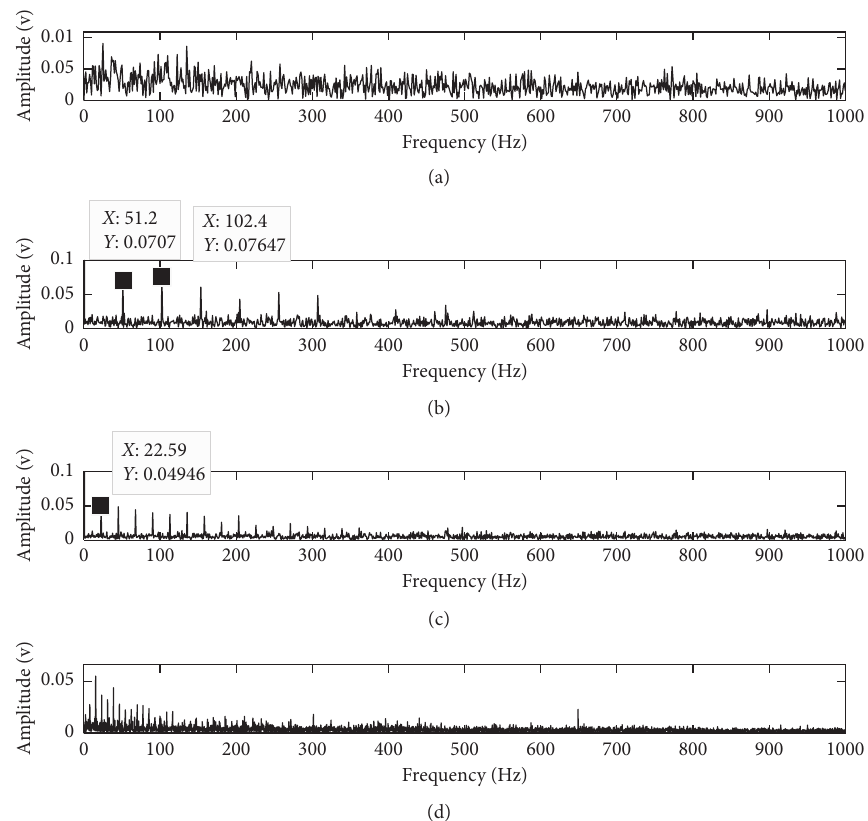
Figure 19: The envelope demodulation spectral analysis results of the signals as shown in Figure 18.